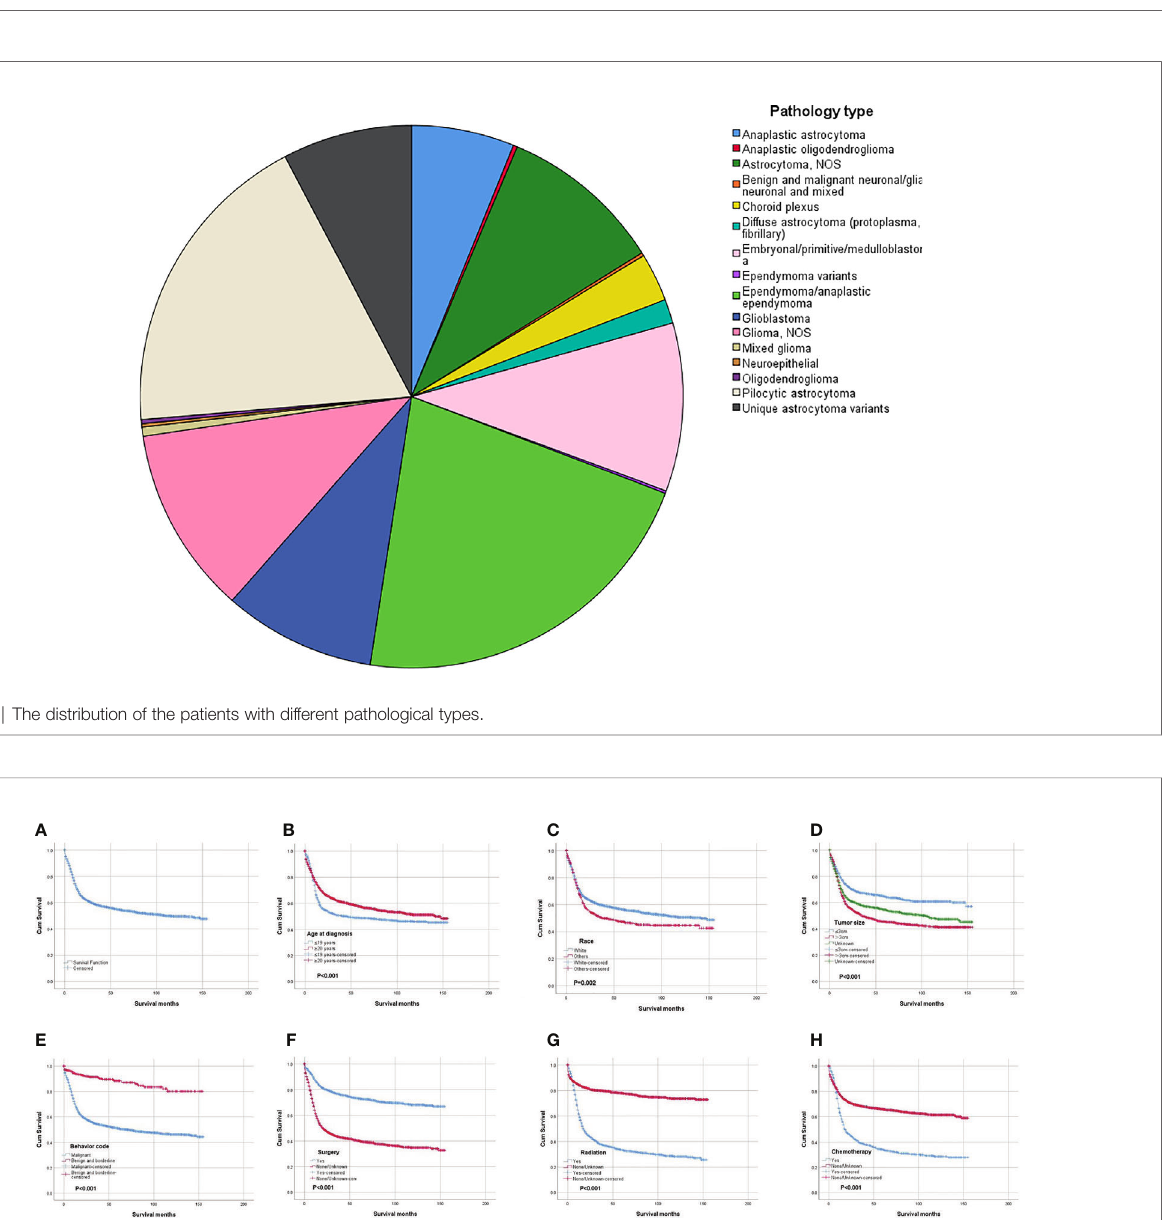
FIGURE 4 | Kaplan-Meier survival analysis: (A) The overall survival for the whole cohort. The survival analysis of patients classi fi ed based on (B) age at diagnosis, (C) race, (D) tumor size, (E) behavior, (F) surgery, (G) radiation and (H)